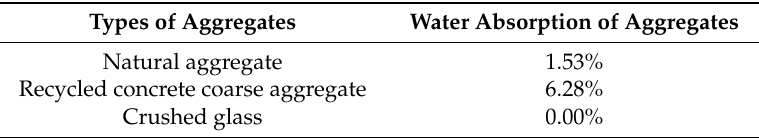
Table 5. Water absorption of aggregates.